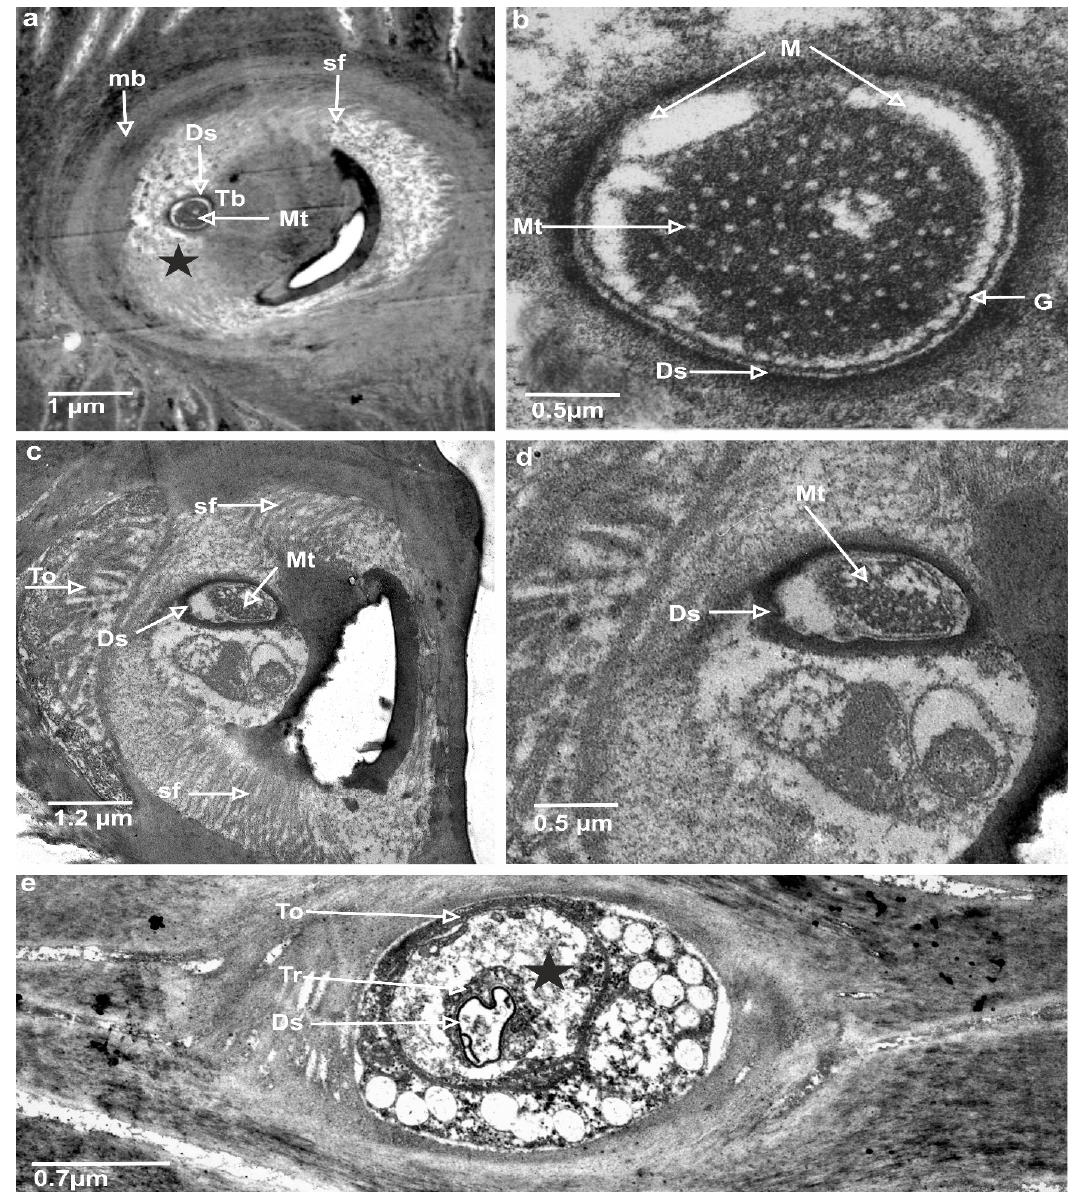
Figure 6. TEM photograph explores the ultrastructures of the trichoid mechanoreceptor: ( a ) cross- section at the base of trichoid mechanosensillum, where tubular body (Tb) is visible; socket membrane or joint membrane (mb) ( b ) magnification microtubules (Mt) of the tubular body; ( c ) profound location of the mechanoreceptor, where tubular body is wider in this section of trichoid mechanosensillum; ( d ) enlargement and the shape of the tubular body; ( e ) tormogen cell (To) with the sensillum lymph cavity (marked star) and trichogen cell (Tr), dendrite sheath (Ds), line of granules (G), suspension fibre (sf), and membrane